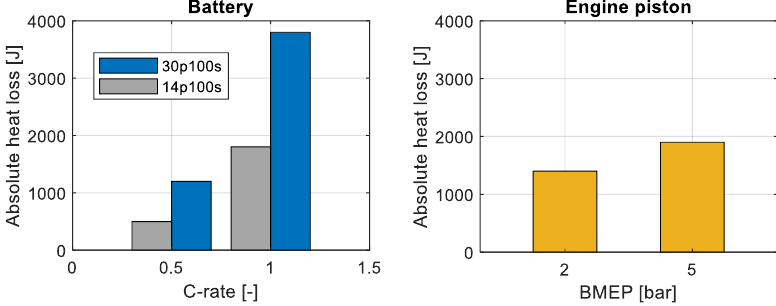
Figure 15. Absolute heat losses for two battery packs and an equivalent engine.